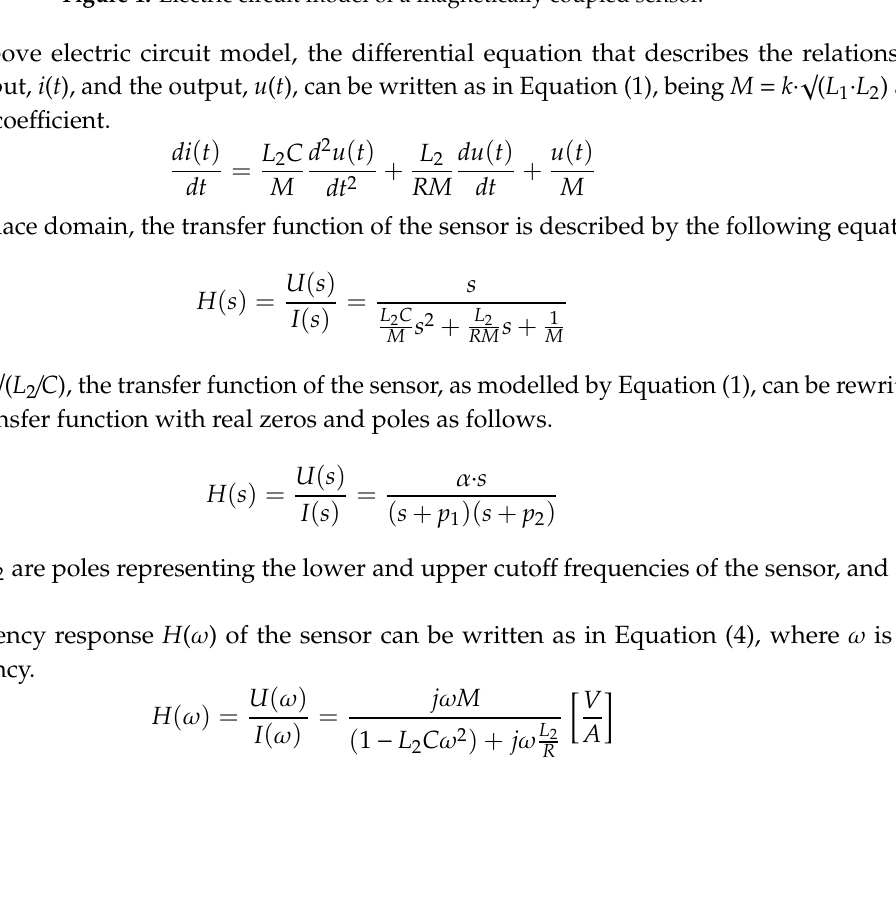
Figure 1. Electric circuit model of a magnetically coupled sensor.